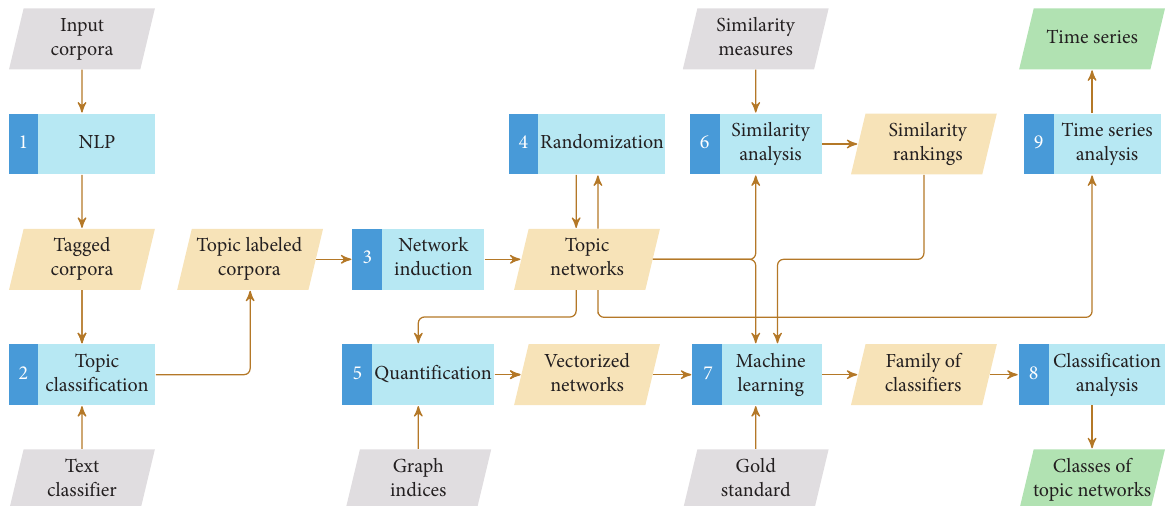
Figure 14: A procedural model of investigating LMNs and MTNs: generating, randomizing, and quantifying topic networks in 9 steps including Natural Language Processing (NLP) (1), topic classification using a classifier θ according to Definition 2 (2), topic network induction according to Definition 8 (3), network randomization according to Section 3.2.4 (4), network quantification (5), and network similarity analysis (6) both based on Section 3.2.6, machine learning of network classifiers (7) and classification analysis (8) both based on Section 3.2.7, and finally, time series analysis of topic networks (which will not be performed here)